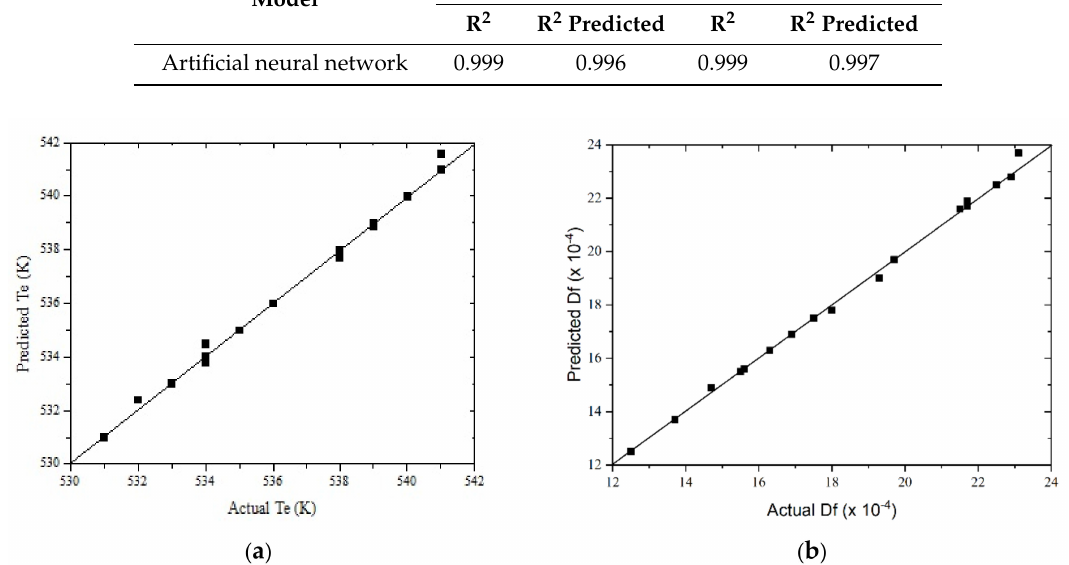
Figure 14. Predicted vs. experimental results of the neural network for: ( a ) T e , and ( b ) D f .